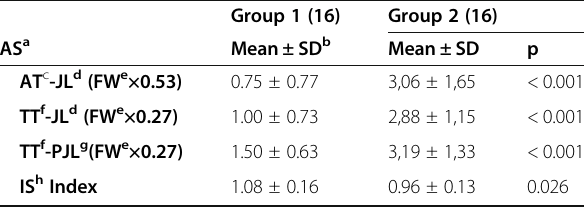
Table 2 Difference between JL that should be according to FW and JL measured on postoperative X-rays Group 1 (16) Group 2 (16) AS a Mean ± SD b Mean ± SD p AT c -JL d (FW e